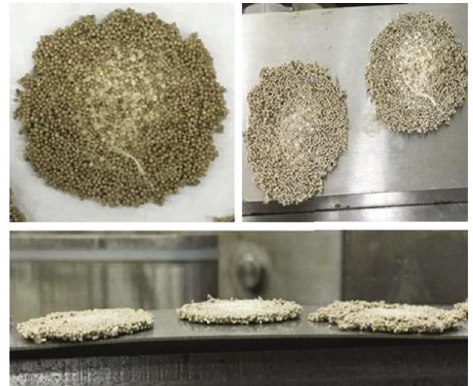
Figure 5: Proppant column after experiment.